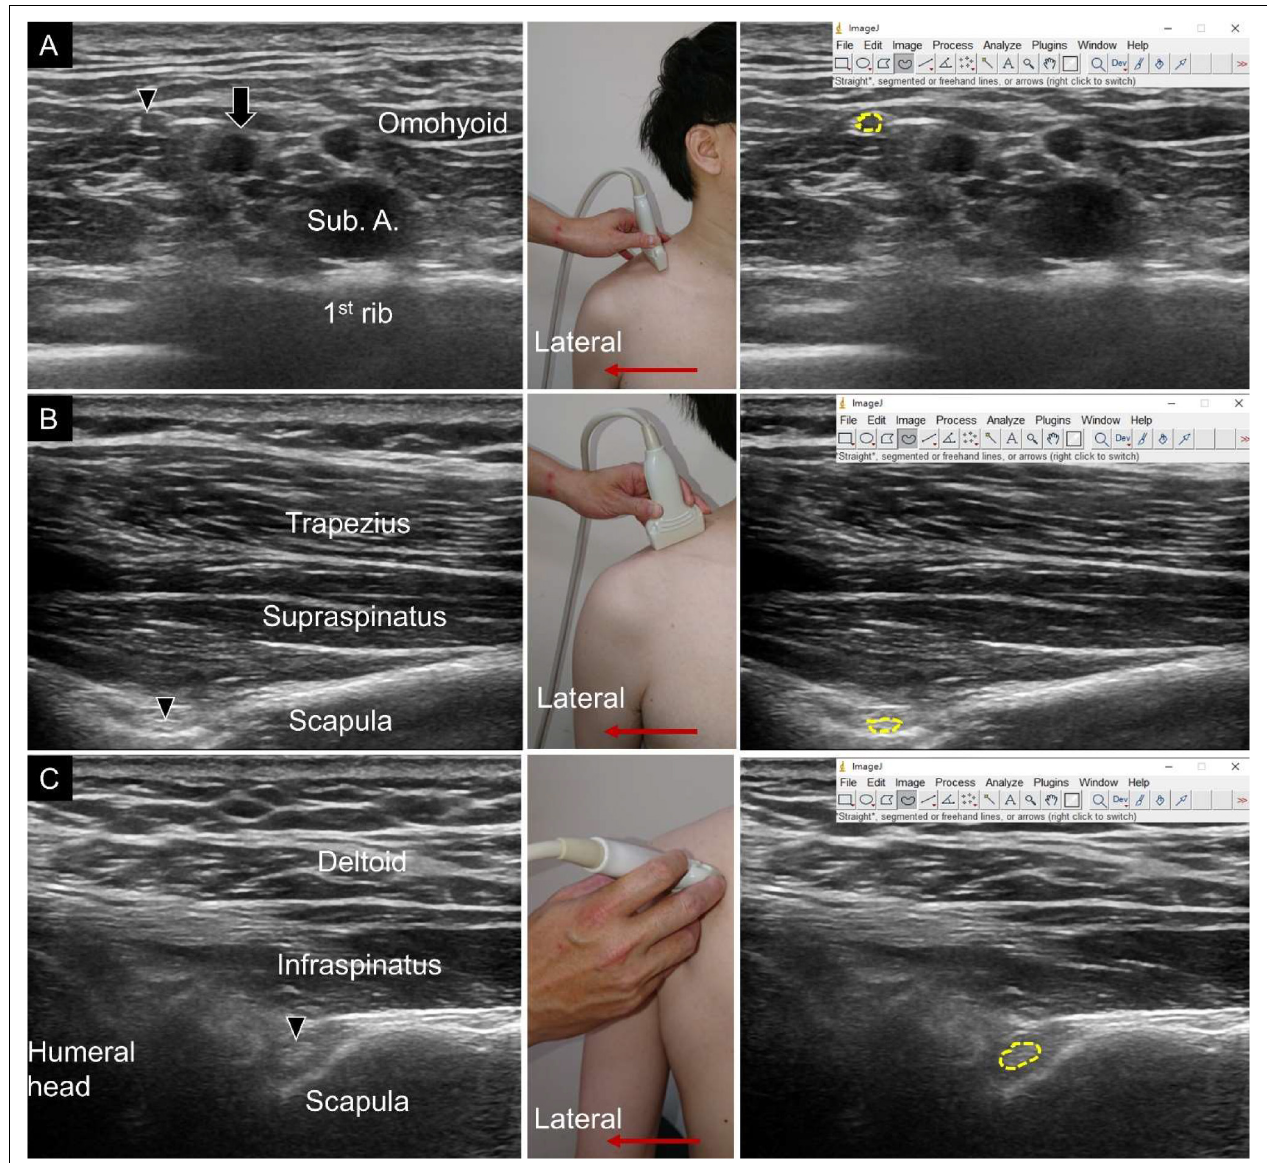
FIGURE 1 | Ultrasound imaging (left subgraph), transducer placement (middle subgraph), and cross-sectional area measurement (right subgraph) for the suprascapular nerve near the brachial plexus (A) , at the supraspinatus fossa (B) and at the infraspinatus fossa (C) . Suprascapular nerve, black arrowheads; brachial plexus, black arrow; Sub. A, subclavian